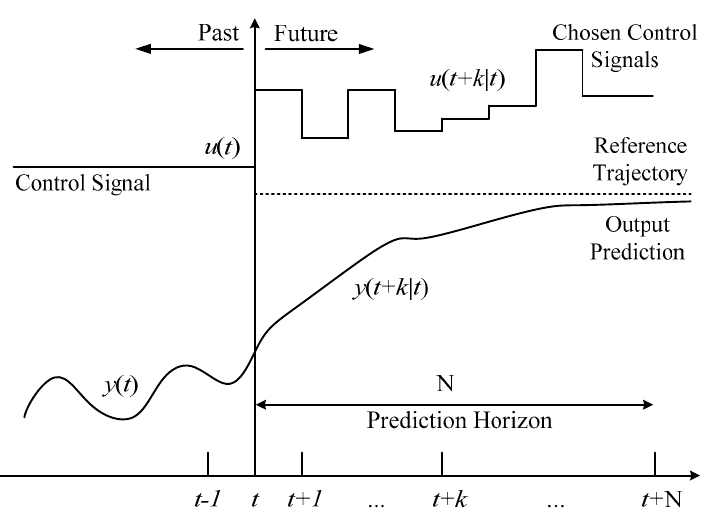
Figure 3. The strategy of the MPC.